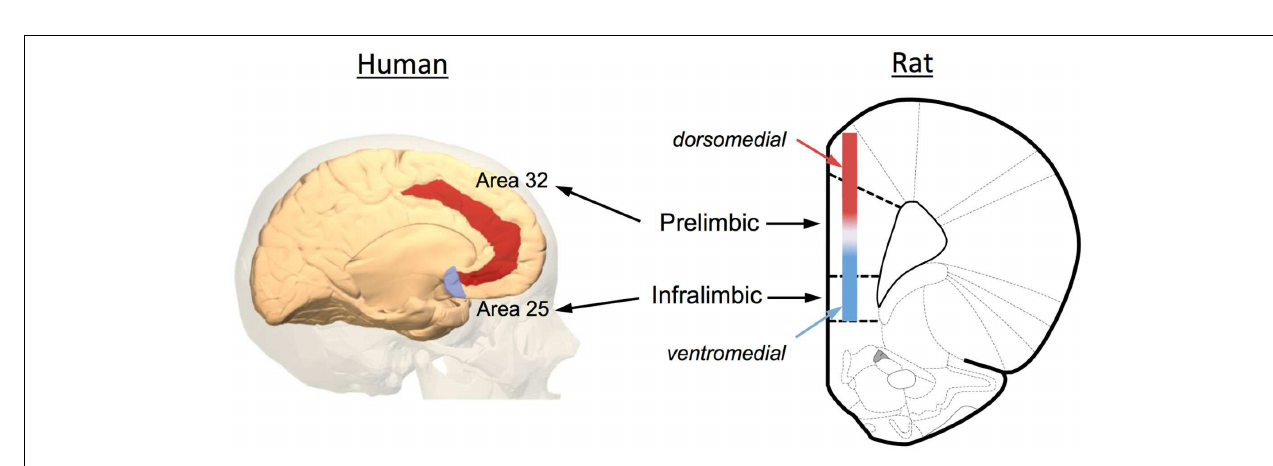
investigators simply divide the rodent medial PFC into a dorsomedial and ventromedial region as illustrated in the diagram.The original image of the human brain shown on the left was modified from an image downloaded fromWikipedia (http://en.wikipedia.org/wiki/ File:Brodmann_area_32_medial.jpg).The original rat brain image shown on the right was modified from Paxinos andWatson (6th